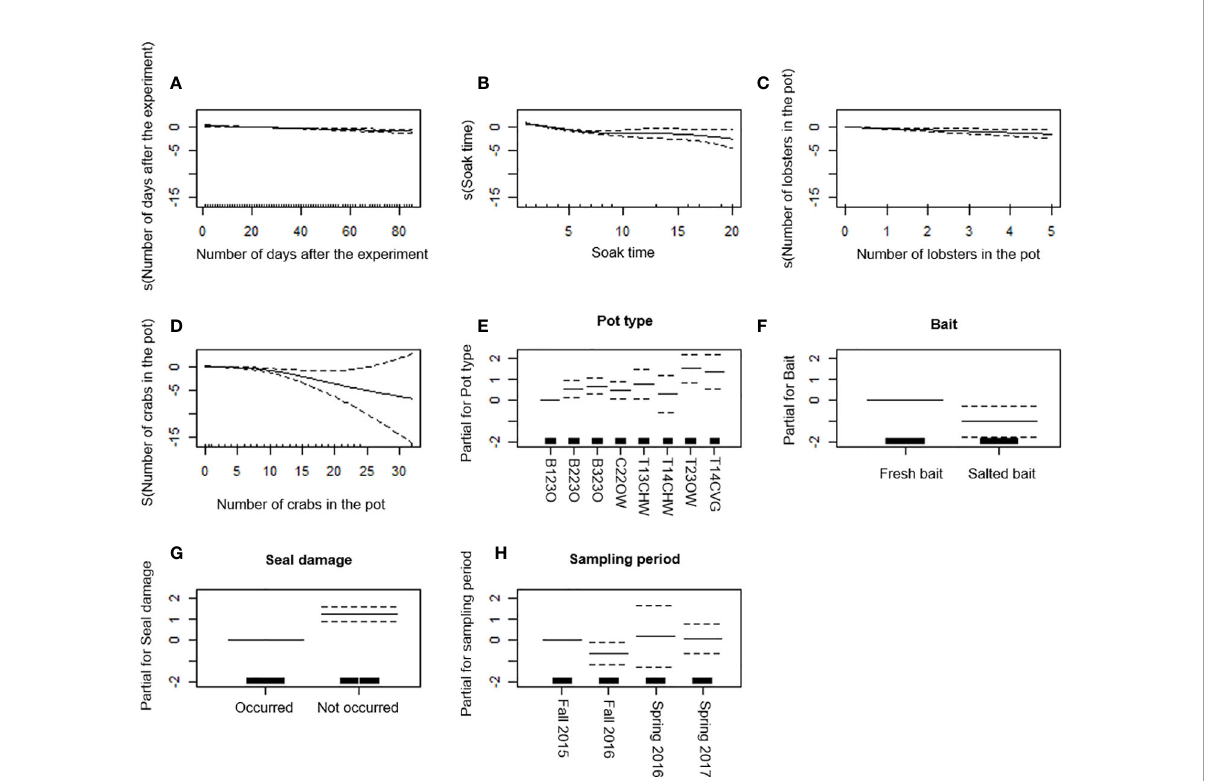
FIGURE 4 Generalized additive model (GAM) partial dependence plots for cod. (A – D) Partial response curves: the x-axis represents the value of the model independent variable whereas the y-axis represents the additive contribution of the variable to the nonparametric GAM smoothing function. Values below zero indicate a negative effect of the variable on the CPUE. (E – H) Partial effects of pot type, bait, seal damage, and sampling period on the CPUE. The dotted line (A – H) represents the 95% con fi dence interval. The black lines on the x-axis represents sample